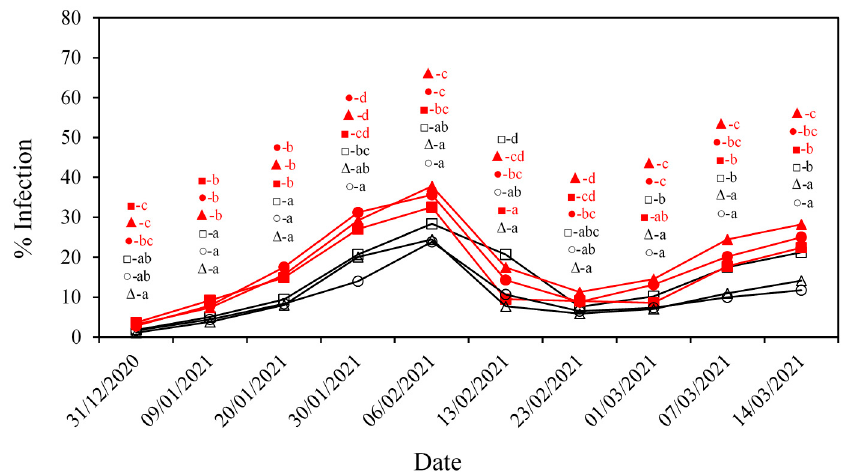
Figure 8. Development of powdery mildew percentage of infection over time in the sectors with different irrigation and crop systems. Treatments: T1-H ( ■ ), T1-S ( □ ), T2-H ( ▲ ), T2-S ( Δ ), T3-H ( ● ) and T3-S ( ○ ). S, typical soil substrate “ enarenado ”; H, coconut fiber substrate. Different letters in the same column show statistically significant differences with a confidence level of 95.0% ( p -value ≤ 0.05).